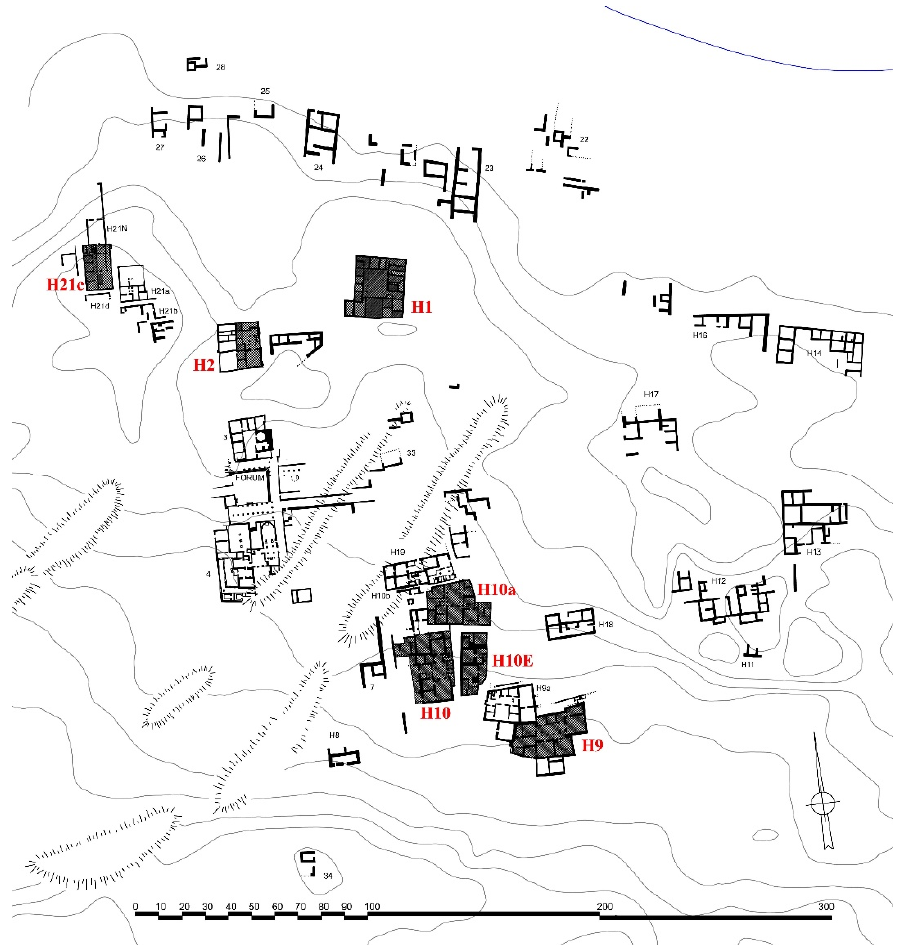
Figure 2. Marina el-Alamein. A plan of the remains of the central part of the ancient town with houses marked where polychrome decorations were found (drawing Karolina Majdzik, Ma ł gorzata Krawczyk-Szczerbi ń ska and Rafa ł Czerner). Table 1. Chronology of the houses. Table 1. Chronology of the